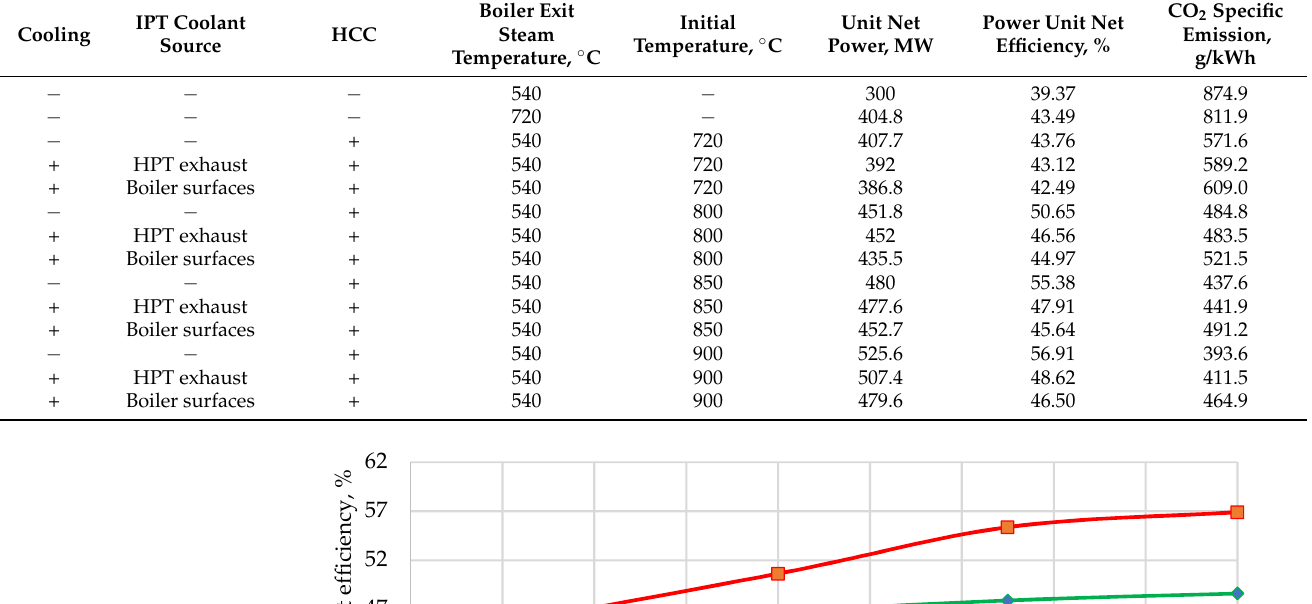
Figure 8. Dependences of the power unit operation parameters on the metal temperature at a 720 °C initial temperature and coolant at 450 °C and 27 MPa: ( a ) HPT and IPT coolant flow vs. metal temperature; ( b ) power unit net efficiency vs. metal temperature. Table 9. Comparison of different units’ parameters.